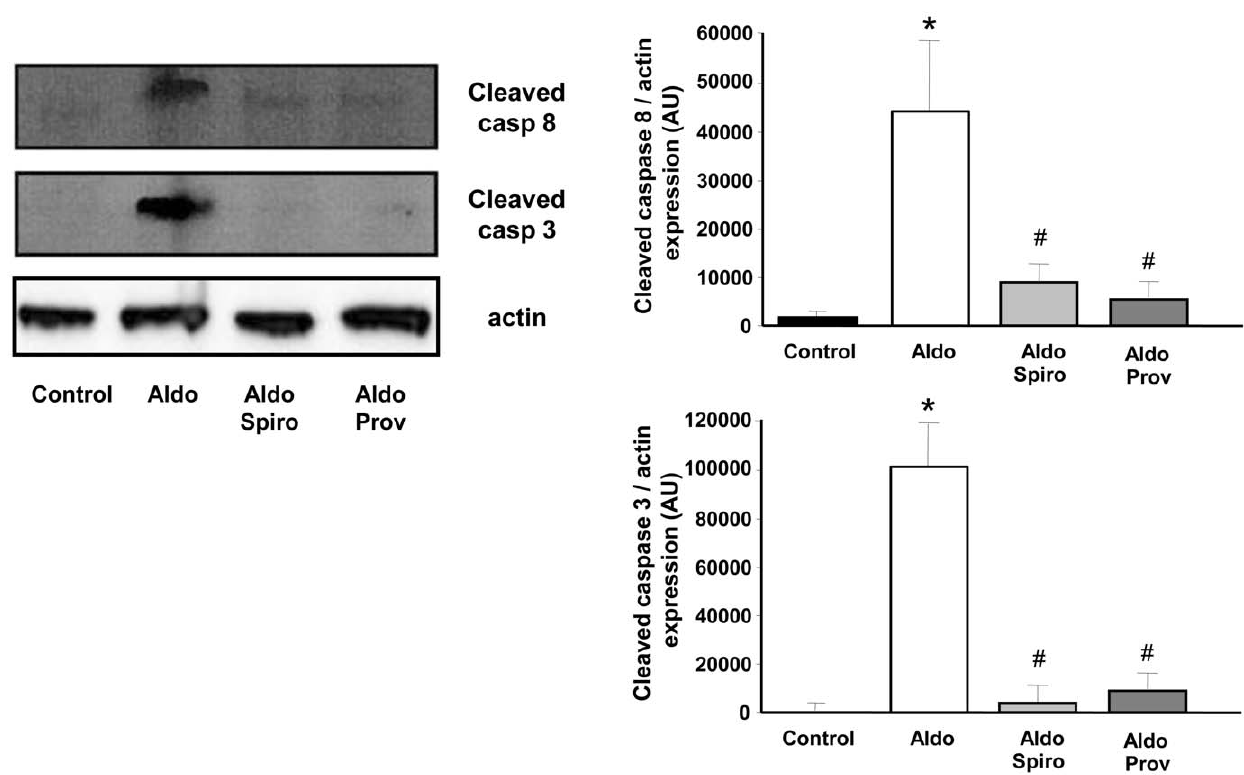
Figure 7. Effects on vessel wall apoptosis. Western blot and densitometric analysis revealing expression of cleaved caspase-8 and caspase-3 in aortae. Data are representative of at least four independent experiments. Values are means 6 SEM, * P , 0.05 vs control rats, # P , 0.05 vs Aldo-salt